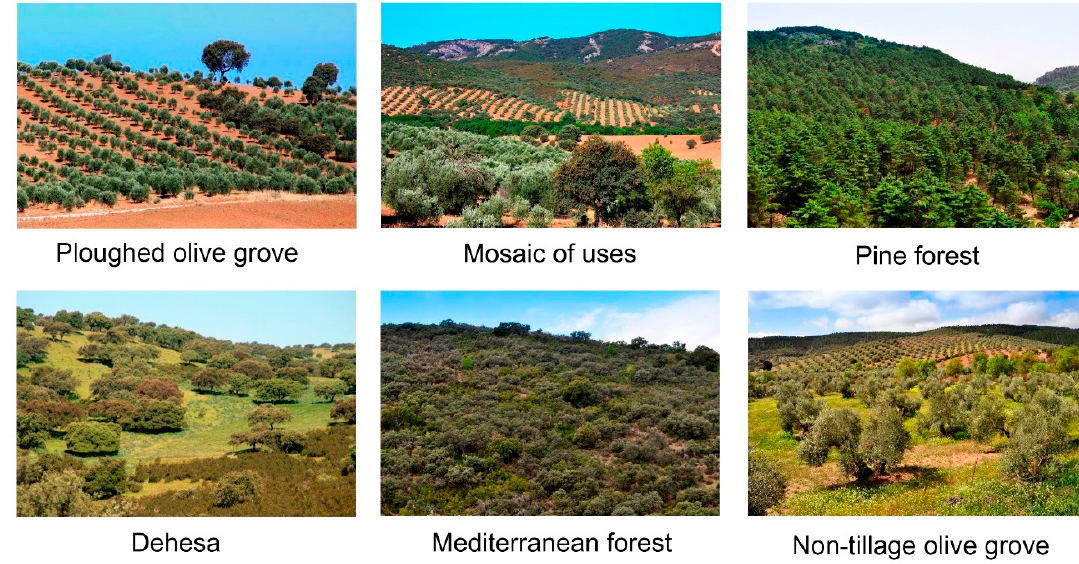
Figure 2. Images of landscapes units used in the ecosystem services valuation.